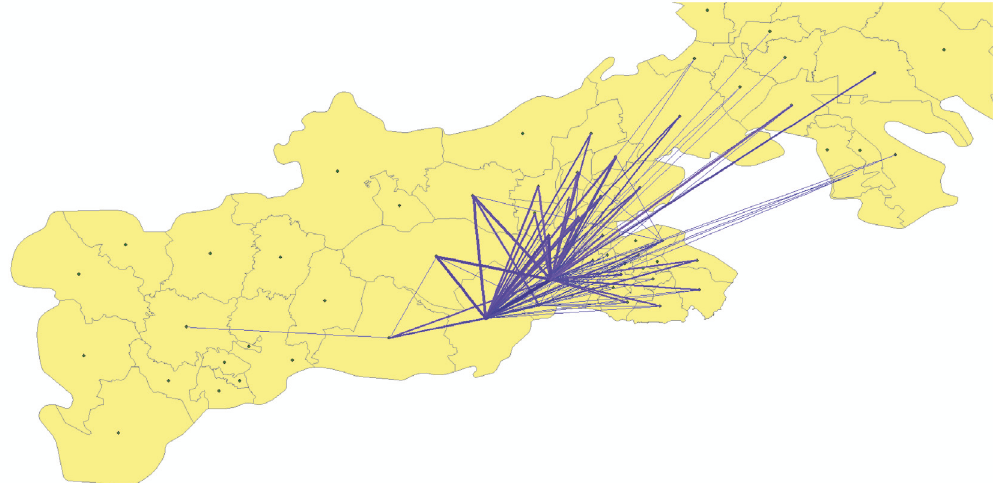
Figure 6: Desire line of CB